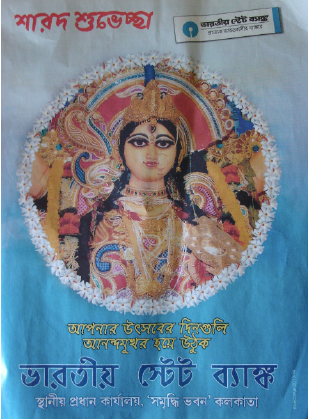
Figure 2. Advertisement for the State Bank of India featuring the goddess Durga